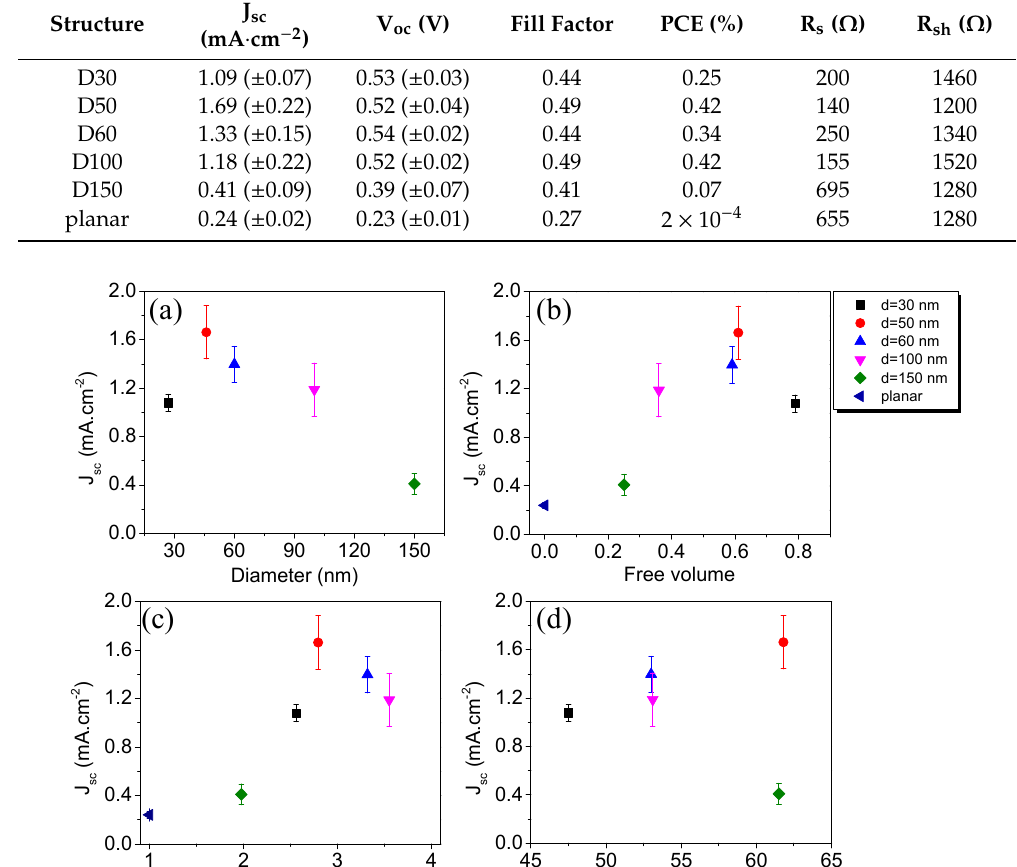
Figure 6. Open circuit voltage variation of Si/GaN NW/P3HT:PC 71 BM ordered heterostructures as a function of GaN NW morphological parameters: ( a ) average diameter; ( b ) free volume—log(f) plot is shown for comparison; ( c ) specific surface; ( d ) pitch. Color online.